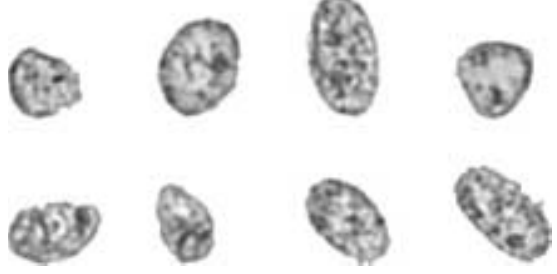
Fig. 2. Four cell nuclei from a good prognosis sample (upper) and four nuclei from a bad prognosis sample (lower). The nuclei were selected from histological